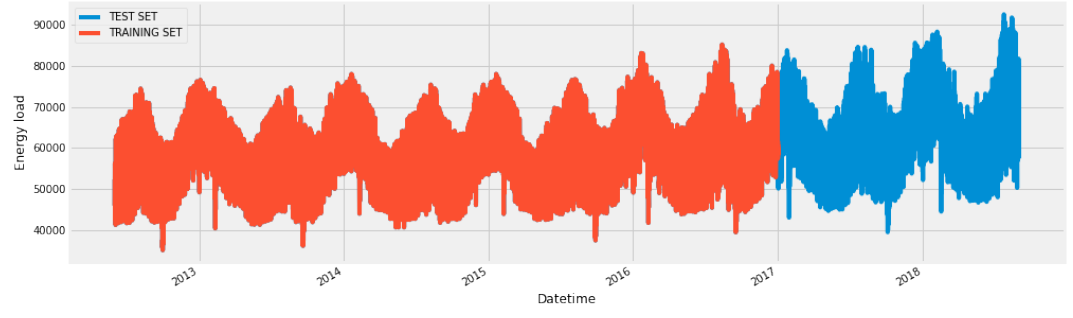
Figure 11. Data split into test and train